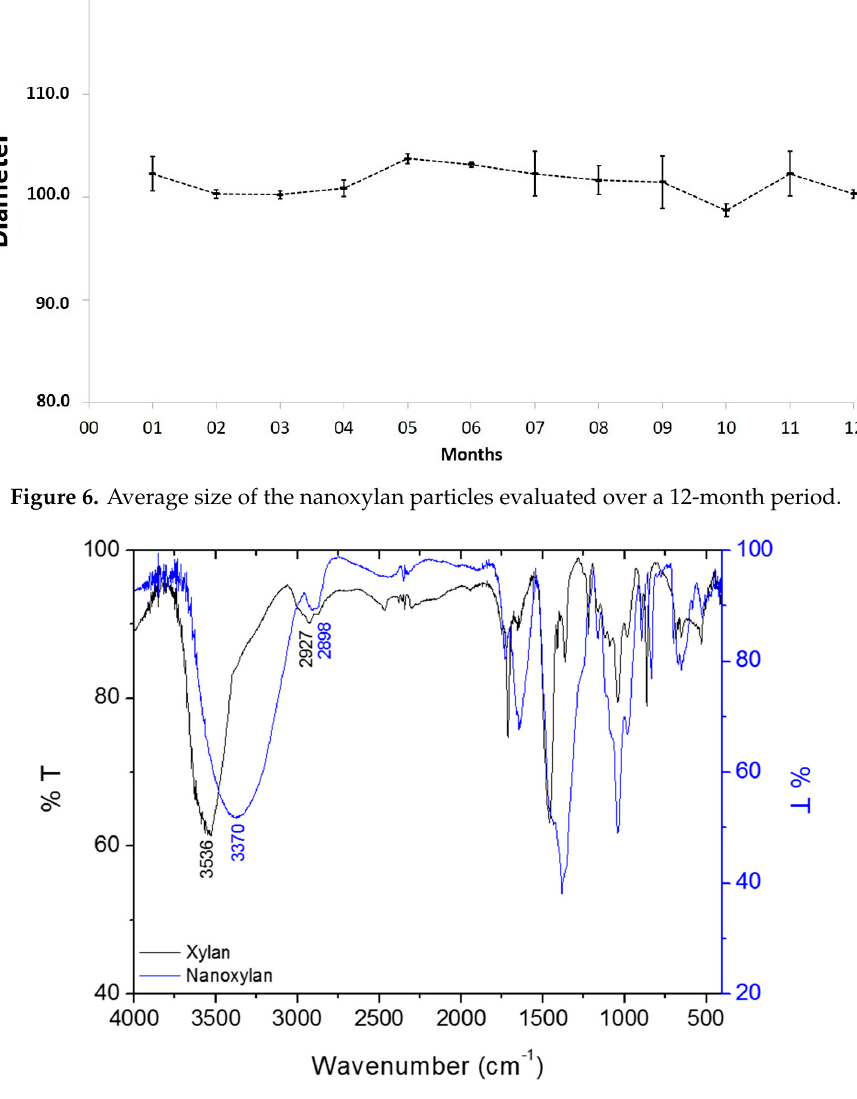
Figure 7. Overlapping infrared spectra for xylan (in black) and nanoxylan (in blue) between 4000 and 400 cm − 1 .